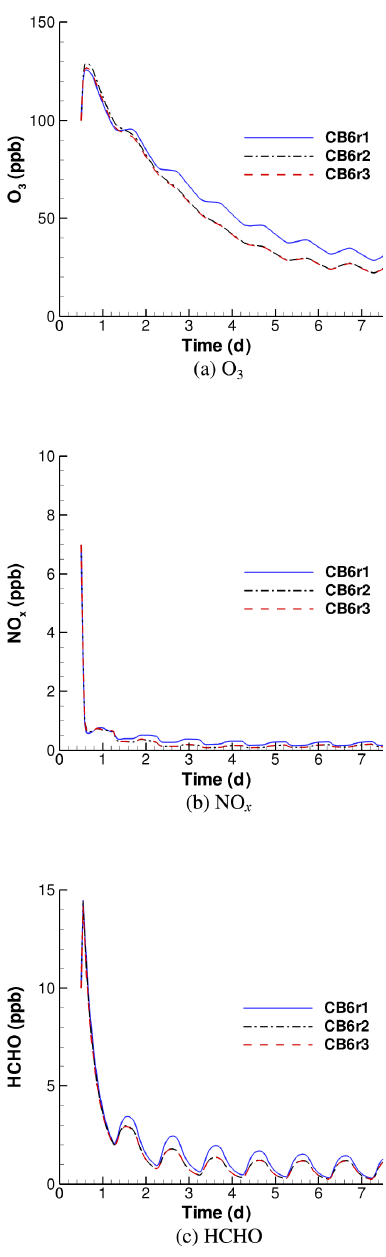
Figure 1. Simulated temporal evolution of O 3 , NO x and HCHO by using different versions of the CB6 mechanism when the surface emission is